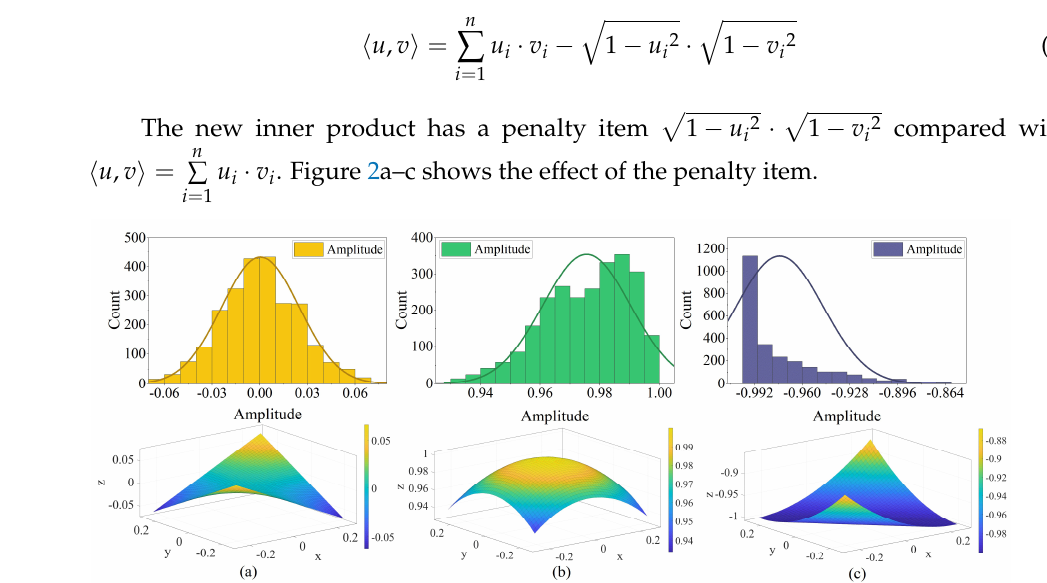
Figure 2. The process of constructing cosine inner product, ( a ) Standard inner product density distribution and 3d image, ( b ) Penalty density distribution and 3d image, ( c ) Cosine inner product density distribution and 3d image.